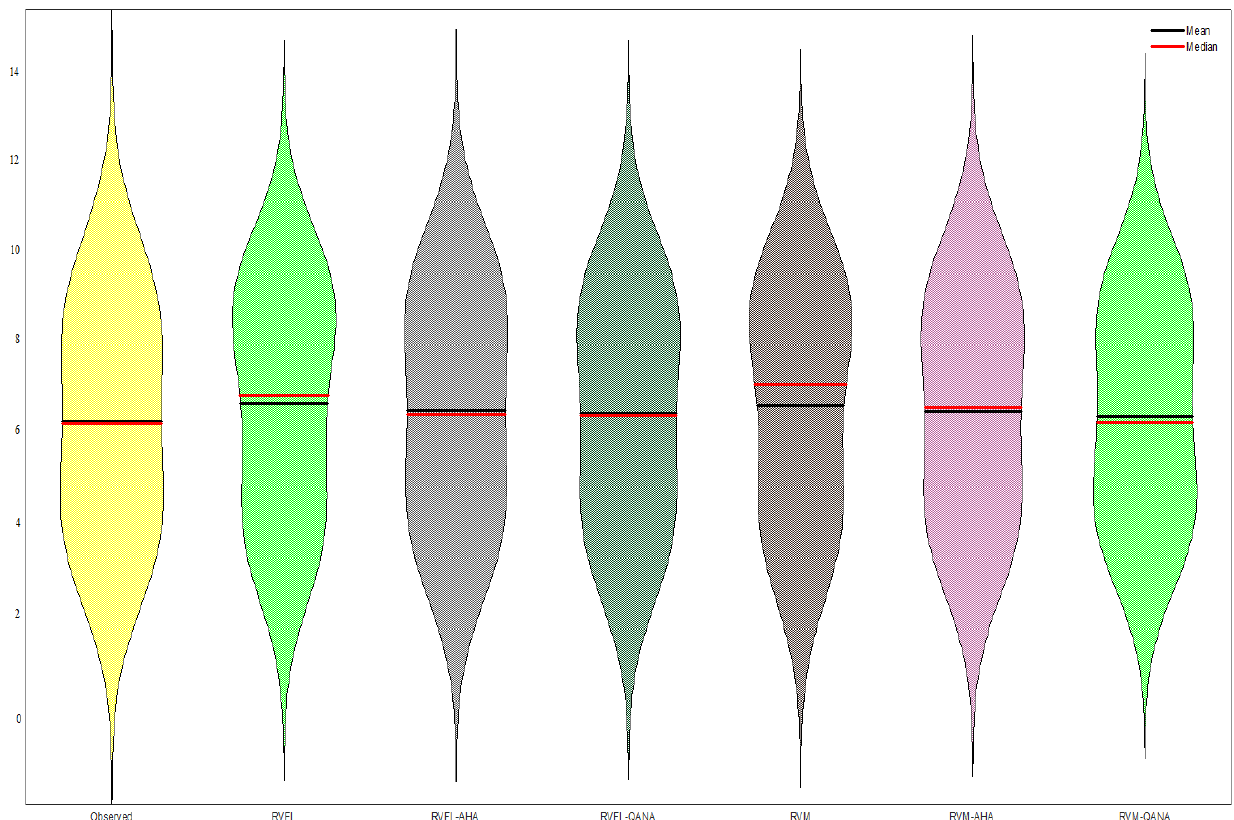
Figure 11. Violin charts of the predicted ET by different RVFL‑ and RVM‑based models in the test period using the best input combination –Station 2 (Peshawar).